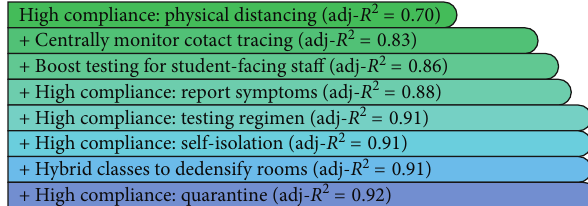
Figure 2: Regression-subset diagram for TAU using the “minimize infections” metric on a university of 6,500 people. The single most important intervention is on the top row, explaining 70% of the variance in the outcome metric according to the adjusted- R 2 test. The second row shows the effect of adding the second most important explanatory factor into the regression (adjusted- R 2 lifts to 0.83). As each new factor is added, there are marginal gains in the adjusted- R 2